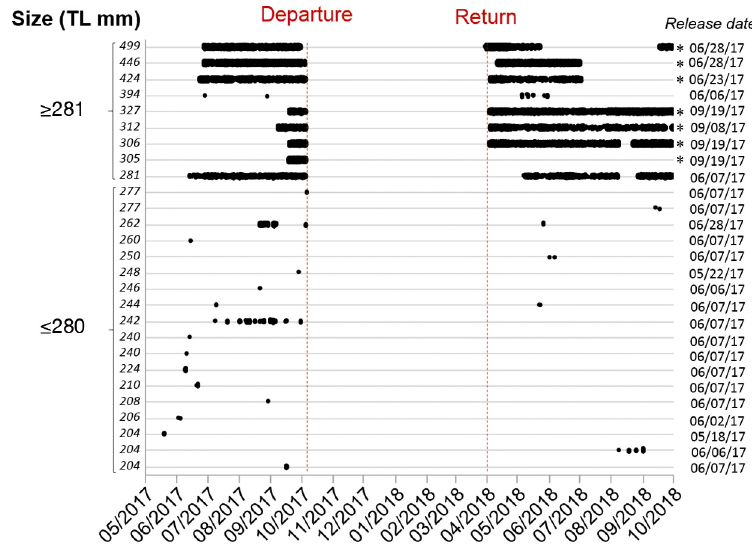
Fig. 5. Daily size-specific seabream detections recorded by the acoustic receiver in the bivalve farm (divided into 2 size categories: ≤280 and ≥281 mm TL), from 20 May 2017 to 30 October 2018. Asterisks indicate that seabream were captured by angling inside the farm; other seabream were captured by traps in shallower parts of the lagoon